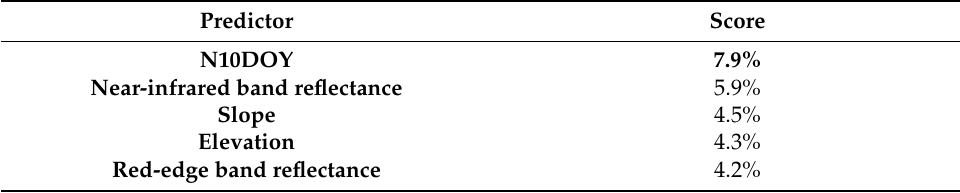
Table 4. Summary of the contribution scores for the five most important predictors.